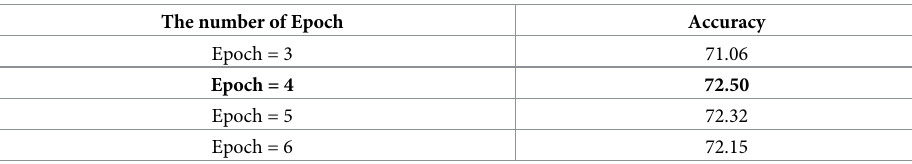
Table 2. Effect of iteration number on model